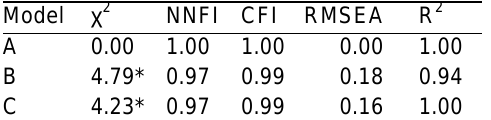
Table 3. Comparison of the nested